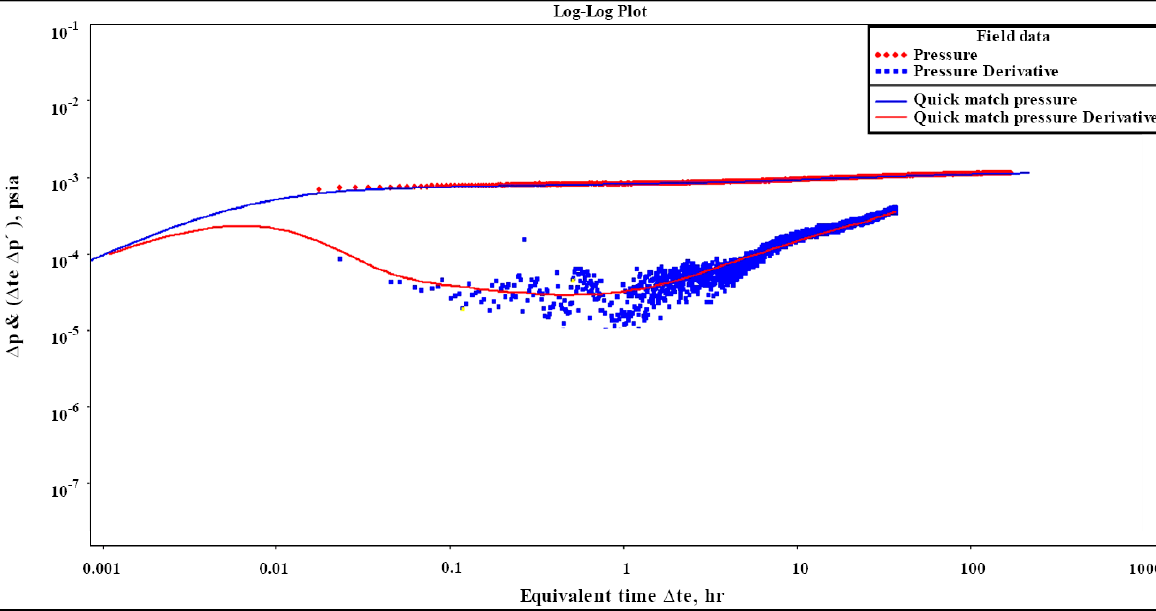
Figure 5. The pressure derivative plot for ND-1 well. Table 5. The results of well test uncertainty analysis (mean value and output percentiles: 10, 50, and 90%) for all pay zones of the studied wells.